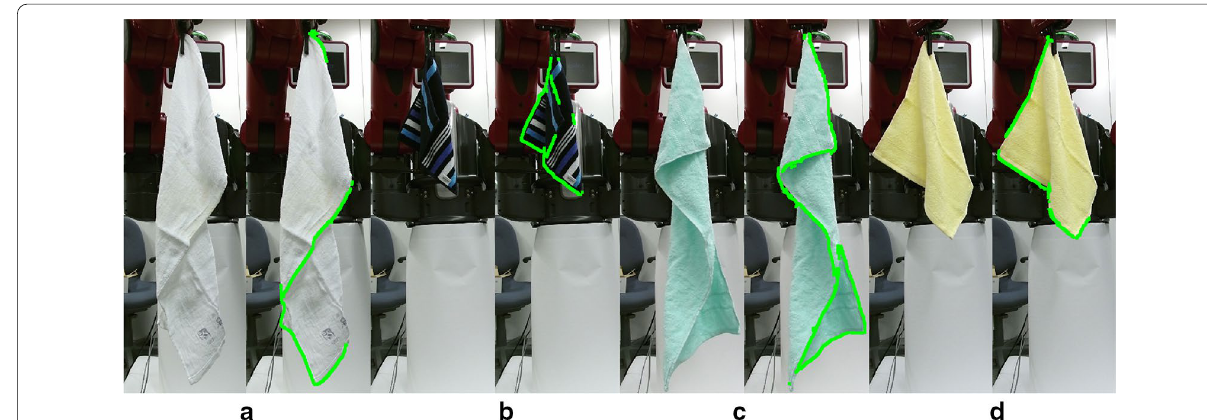
Fig. 14 Examples of edge detection in unseen garments (Cloths a to d respectively)